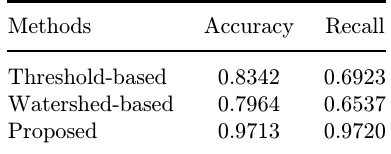
Table 2. Performances of di®erent segmentation